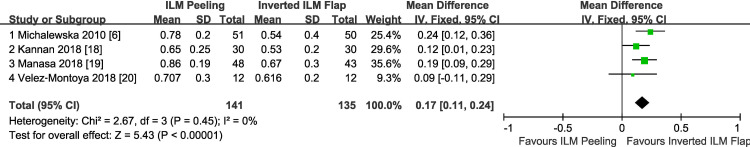
Mean postoperative best corrected visual acuity (logMAR units) comparing inverted ILM flap technique with ILM peeling.ILM, internal limiting membrane; SD, standard deviation; IV, inverse variance; CI, confidence interval.